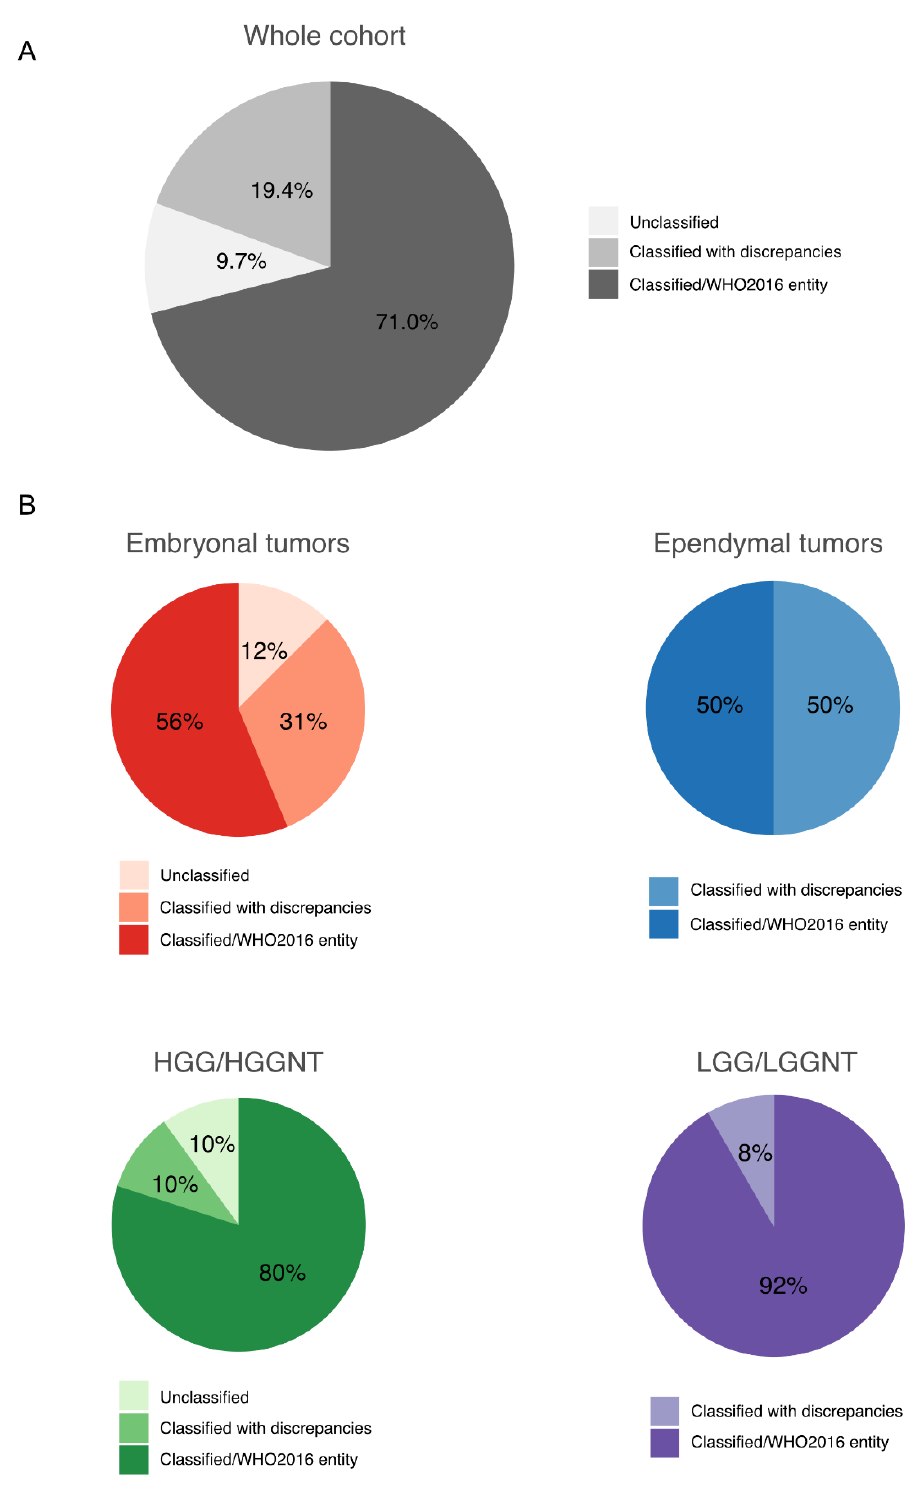
Figure 5. Final data integration results. Proportions of classified and unclassified tumors after integrating all data in the whole cohort ( A ) and in each category of tumors ( B ). HGG/HGGNT = high-grade glial/glioneuronal tumor. LGG/LGGNT = low-grade glial/glioneuronal tumor.